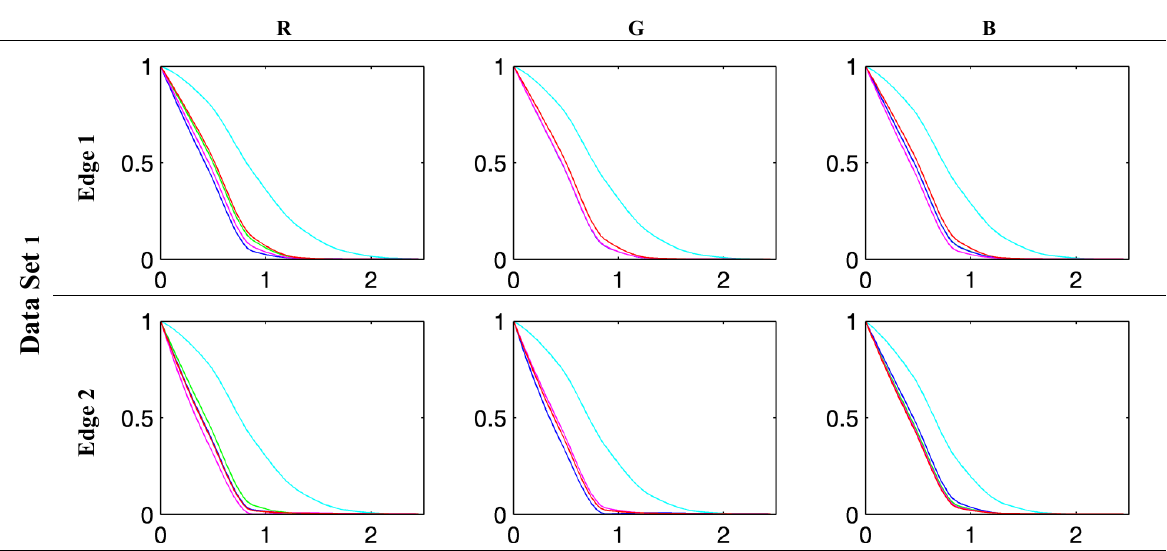
Figure 10. MTF curves, pan-sharpened and reference MS image, x-axis shows the frequency and y-axis the MTF